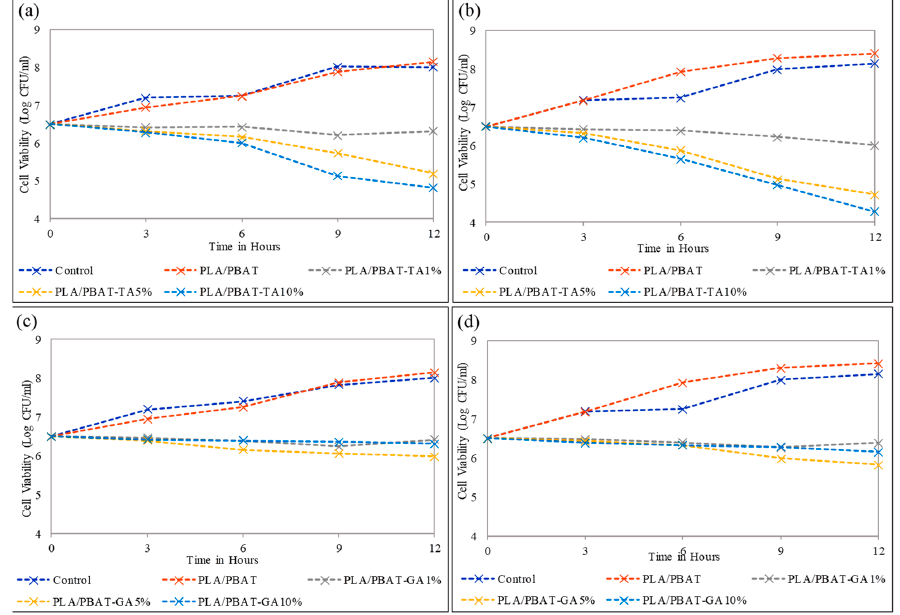
Figure 4. Antibacterial property of composite film: ( a ) effect of tannic acid on E. coli, ( b ) effect of tannic acid on L. monocytogenes, ( c ) effect of gallic acid on E. coli, and ( d ) effect of gallic acid on L. monocytogenes.